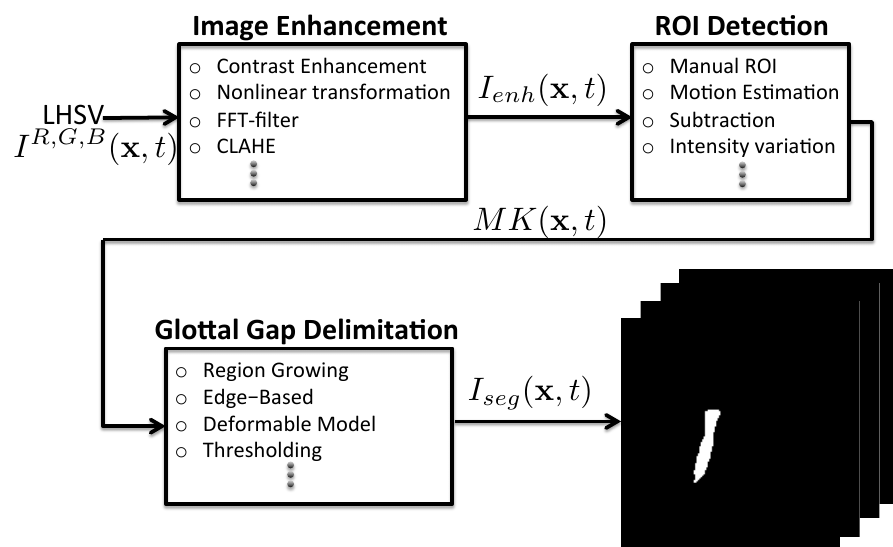
Figure 6. Graphic Representation of the three common steps followed to segment the glottal